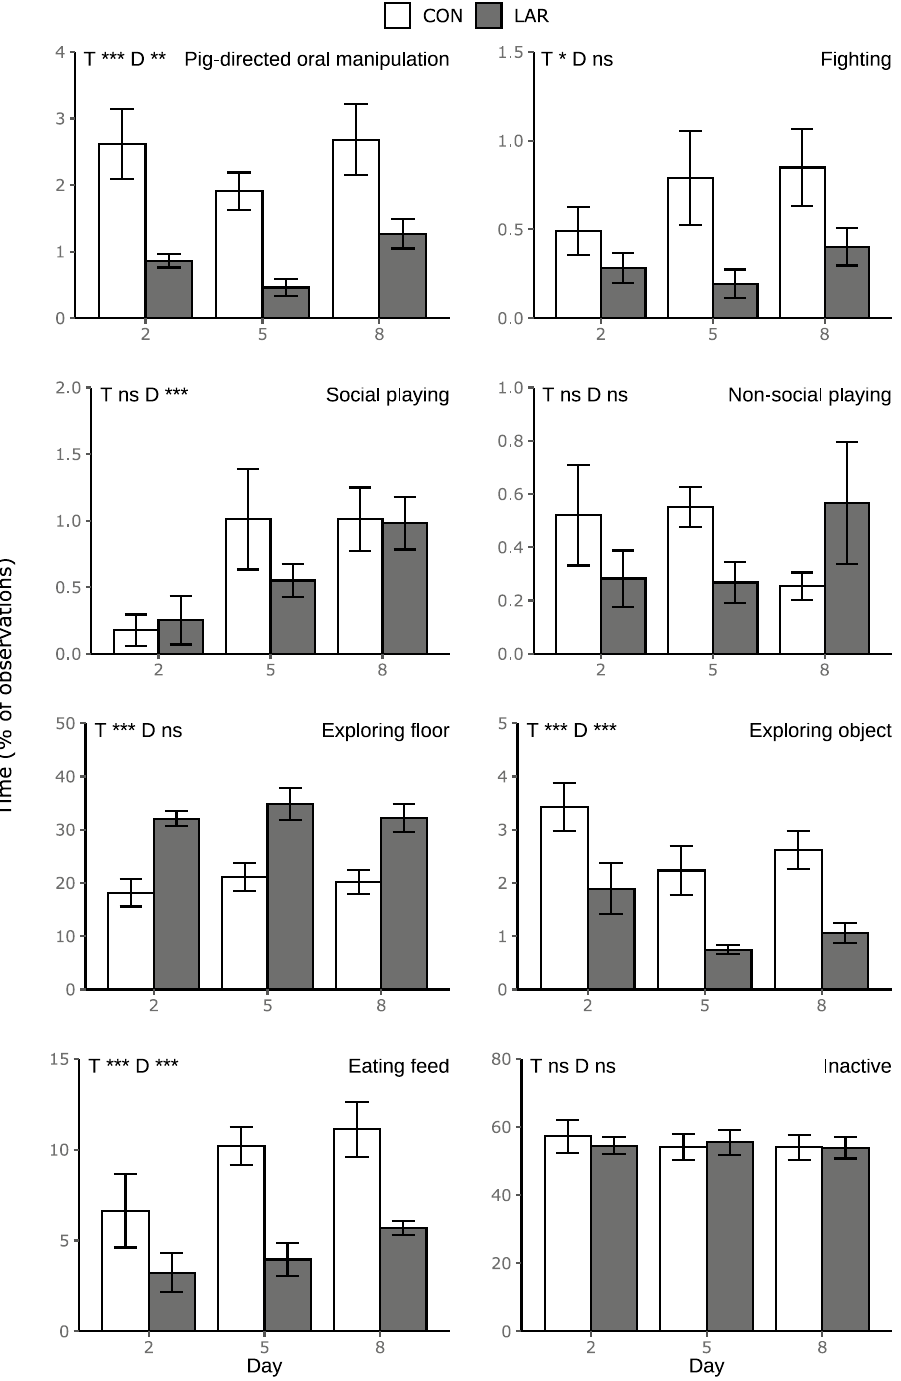
Figure 1. Behaviours observed in the home pen. Behavioural time budgets expressed as pen means ± SEM of pigs receiving wood shavings (CON) or black soldier fly larvae (LAR) twice a day. Effects of Treatment (T) and Day (D) are indicated as ***p < 0.001, **p < 0.01, *p < 0.05 and ns if p > 0.05. The Treatment x Day interaction was never significant and is therefore not